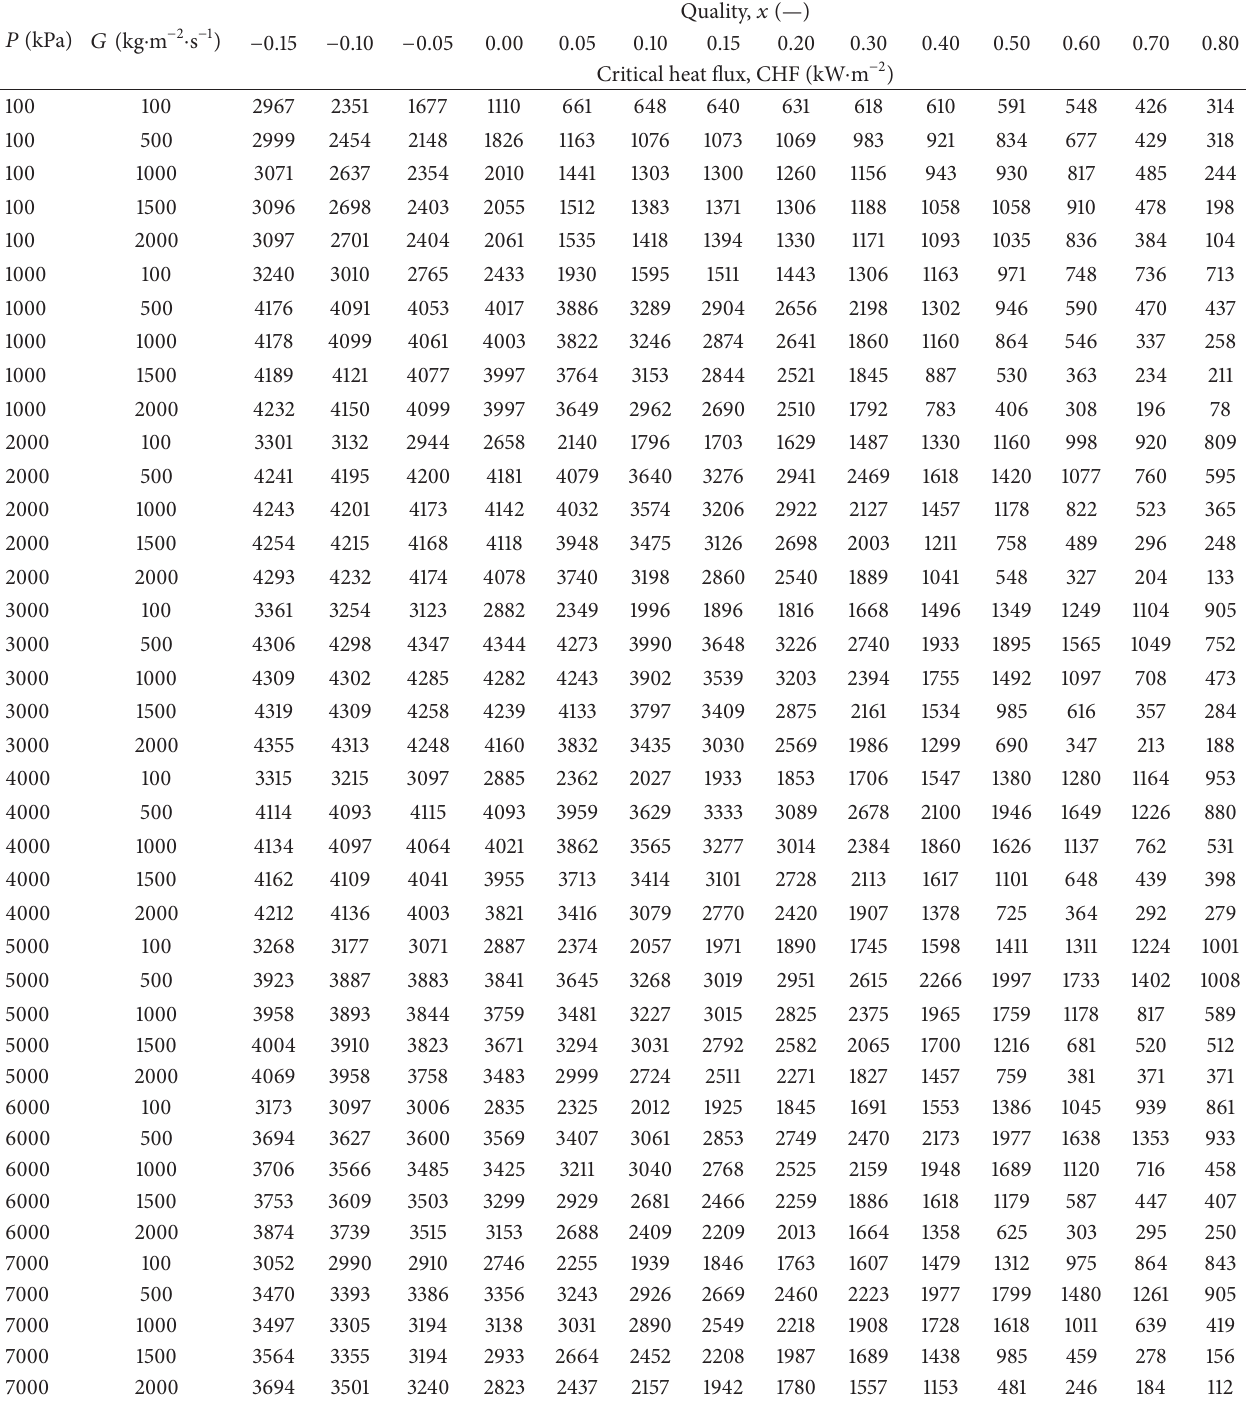
Table 1: CHF-LUT for vertical up-flow in 67mm diameter